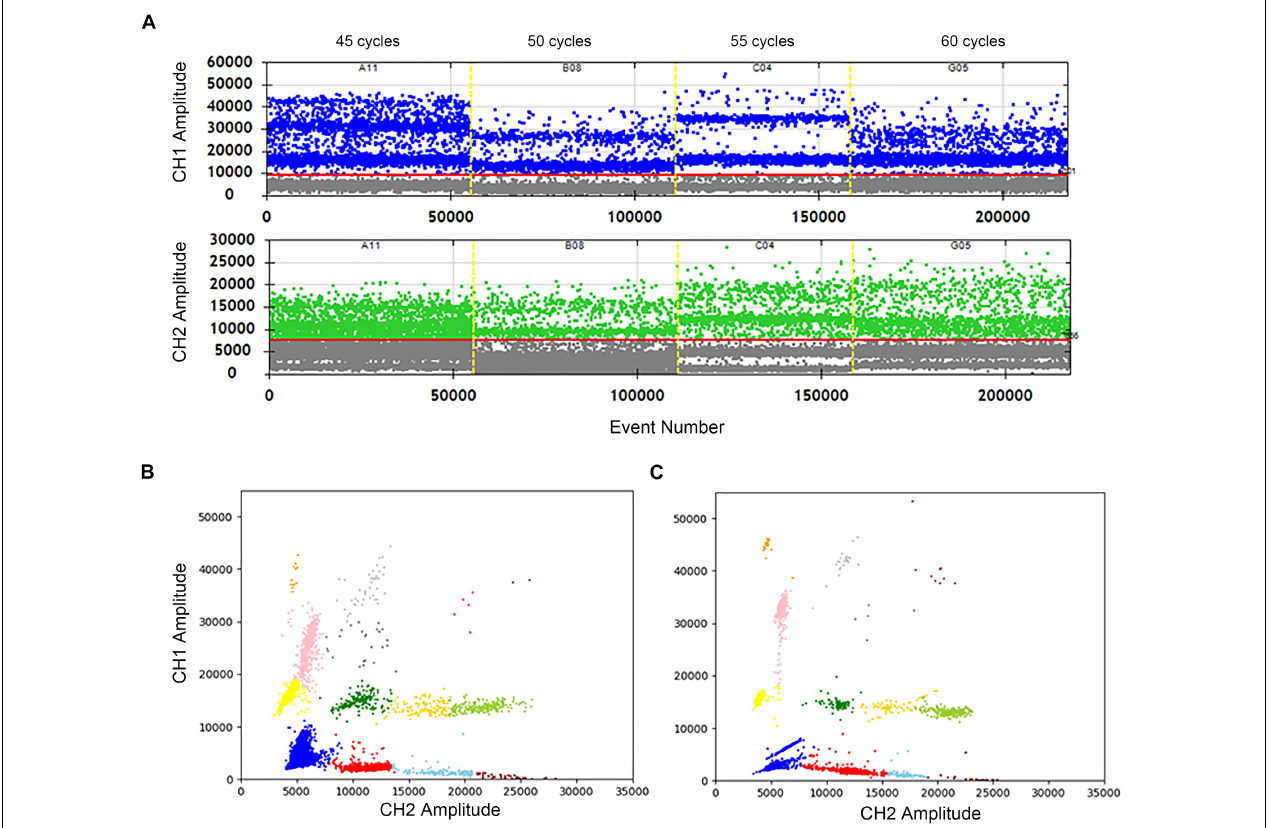
FIGURE 3 | Optimization of the cycle number in two channels and 2D plot. (A) The positive droplets were represented as blue and the negative droplets were represented as gray in FAM. The positive droplets were represented as green and the negative droplets were represented as gray in VIC. (B) The 2D plot was obtained in 60 cycles of the amplification. (C) The 2D plot was obtained in 55 cycles of the